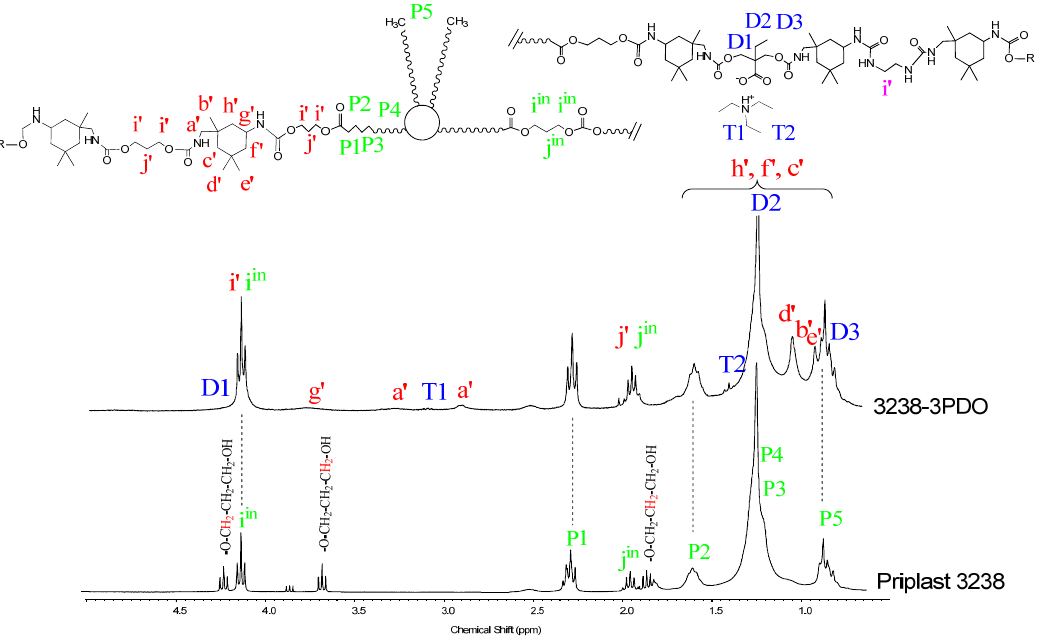
Figure 7. 1 H NMR of experiment 3238-3PDO and starting polyol Priplast 3238 with peak assignments.